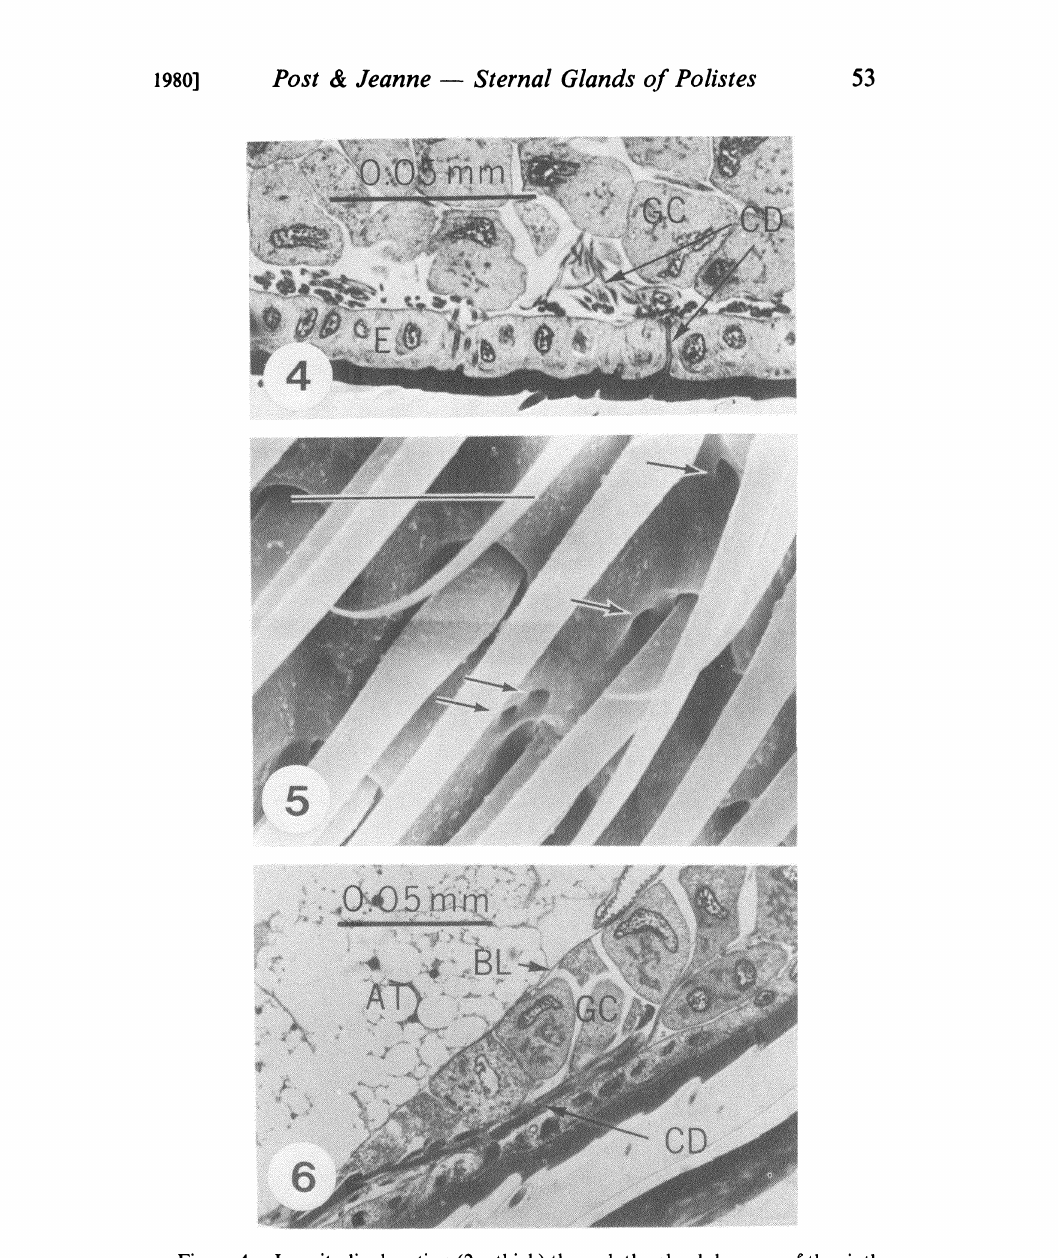
Figure 4. Longitudinal section (2 O thick) through the glandular area of the sixth gastral sternite of P. canadensis. GC---glandular cells; E=epidermis; CD=glandular cell ducts. Figure 5. SEM photograph of the glandular cell duct openings (indicated by arrows) at the base ofthe sternal brush hairs of P.fuscatus. Anterior is to the upper right. Scale 0.05 mm. Figure 6. Transverse section (2 O thick) through the glandular area of the sixth gastral sternite of P. fuscatus. Midline is to the left. GC--glandular cells; AT=adipose tissue; CD--glandular cell ducts; BL--basement